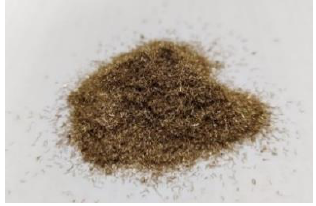
Figure 1. Picture of the brass fibres.